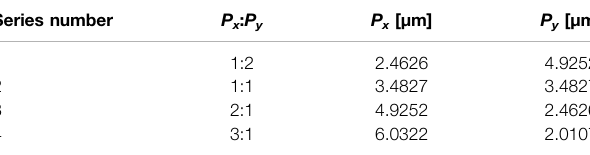
TABLE 3 | Geometrical parameters for GCWA associated with Figure 4B .